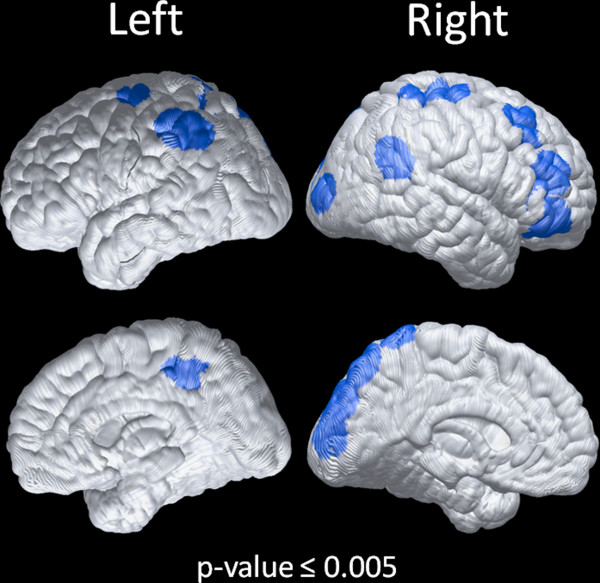
Statistical cortical surface map for voxel-wise group comparison between subjects with and without DLB covarying out the effects of ADAS-Cog. Brain areas of significant hypometabolism in DLB were shown with an uncorrected threshold of p ≤ 0.005.